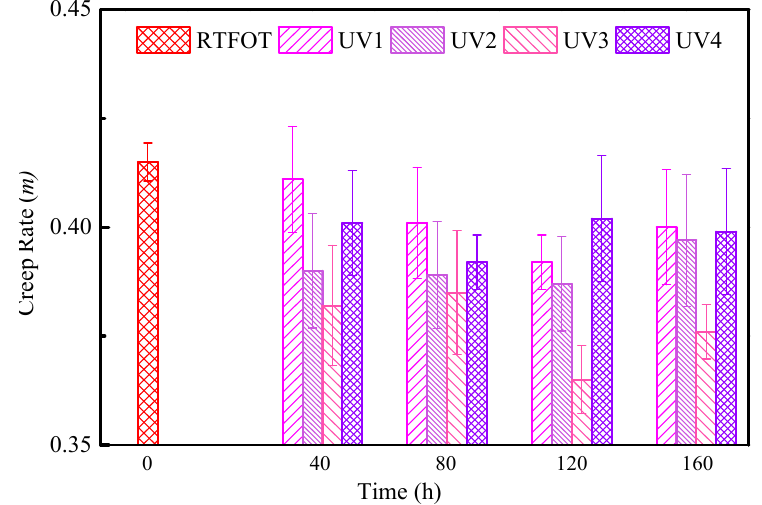
Figure 7. Creep rate ( m value) of SBS-modified asphalt binders under UV and RTFOT aging.